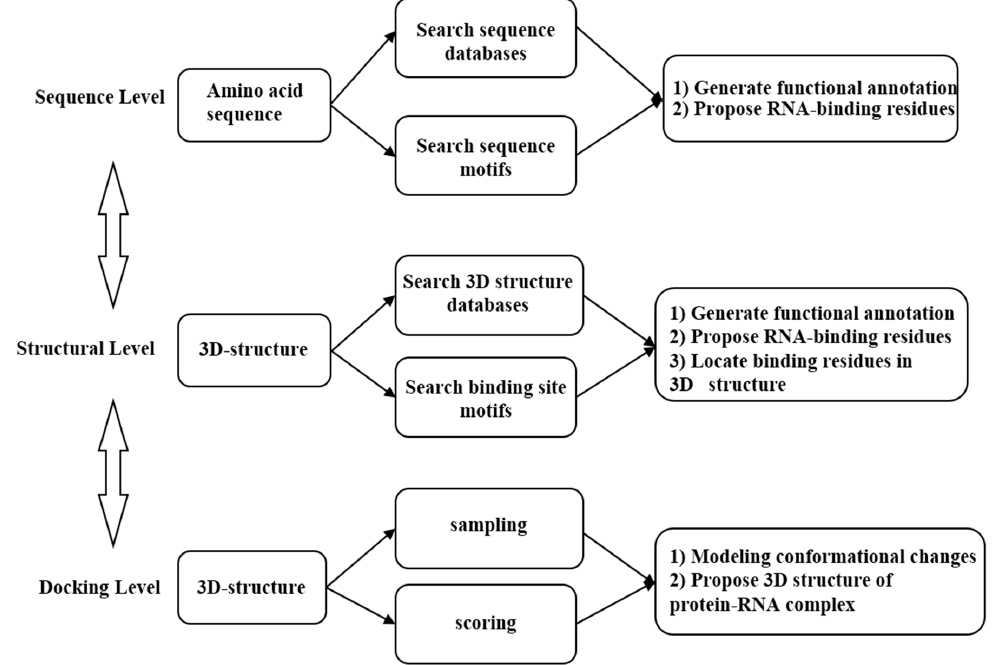
Figure 1. Strategies for RNA-binding site and RBP prediction.